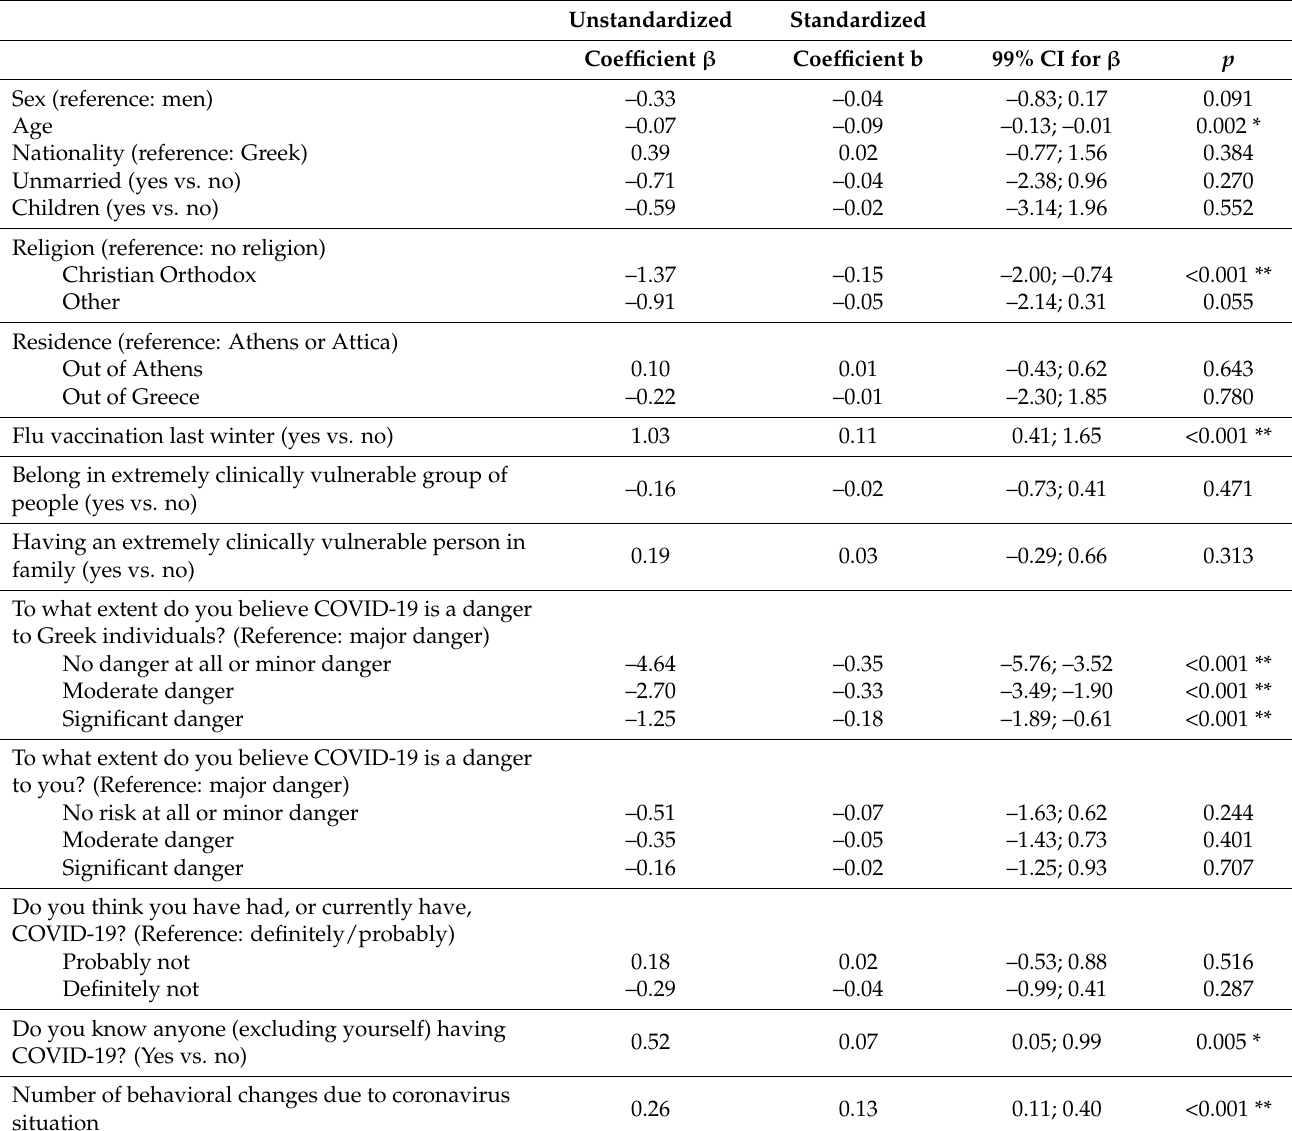
Table 5. Multiple linear regression analysis results having students’ intention to get vaccinated against COVID-19 as dependent variable and their characteristics, their perceptions for the pandemic, and number of behavioral changes that they undertook due to pandemic as independent